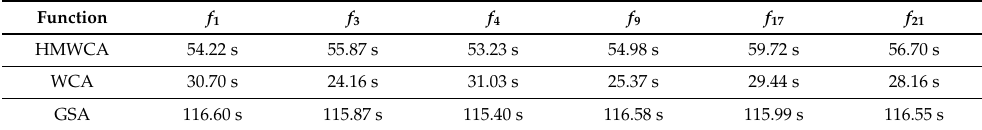
Table 6. The average CPU time of the HMWCA, WCA and GSA. Function f